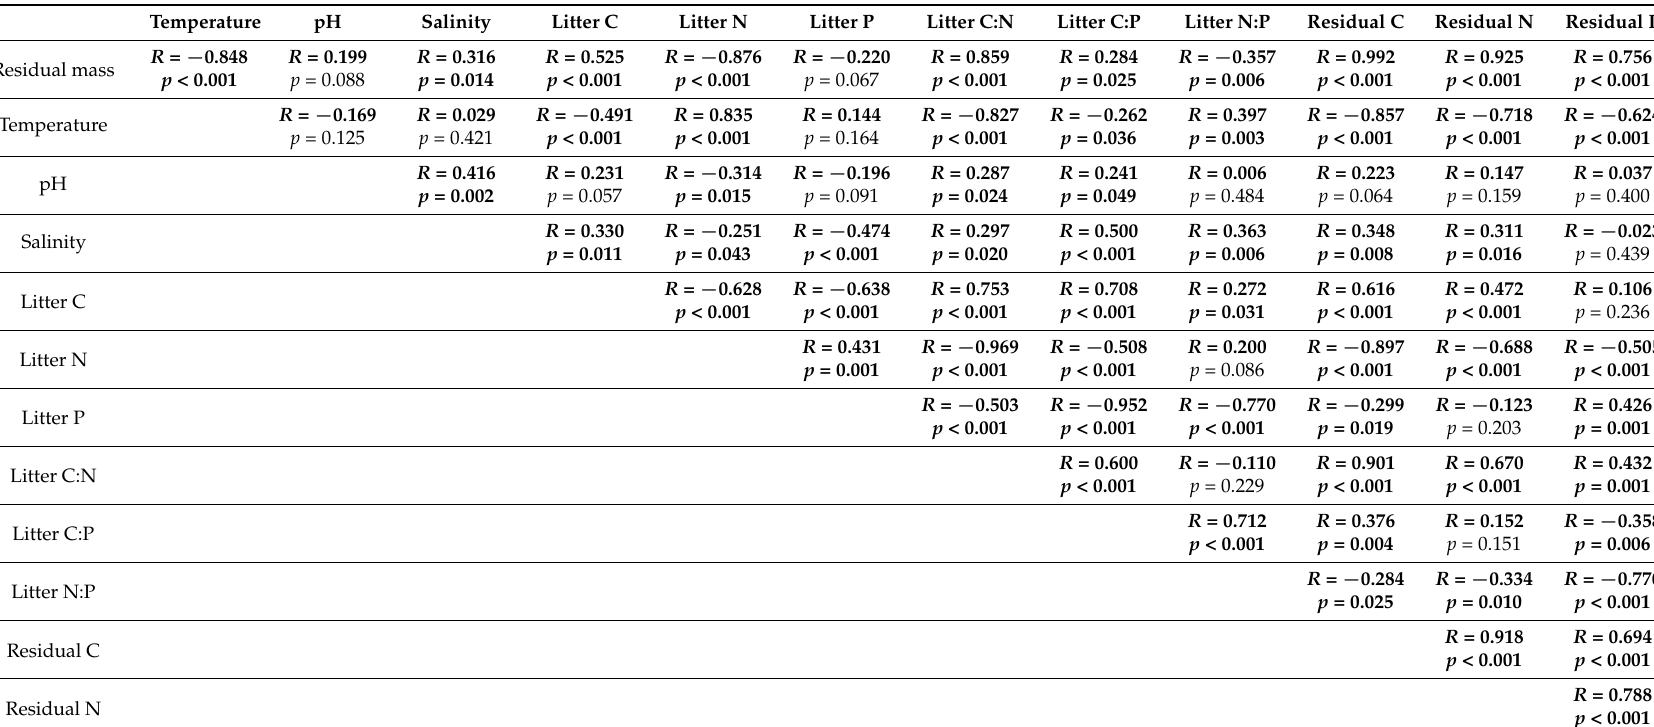
Table A3. Pearson correlations among the residual mass in the straw bag (%), nutrient concentrations (mg g − 1 ) and ratios, and physical soil traits. Bold type indicates significant differences ( p < 0.05). Temperature pH Salinity Litter C Litter N Litter